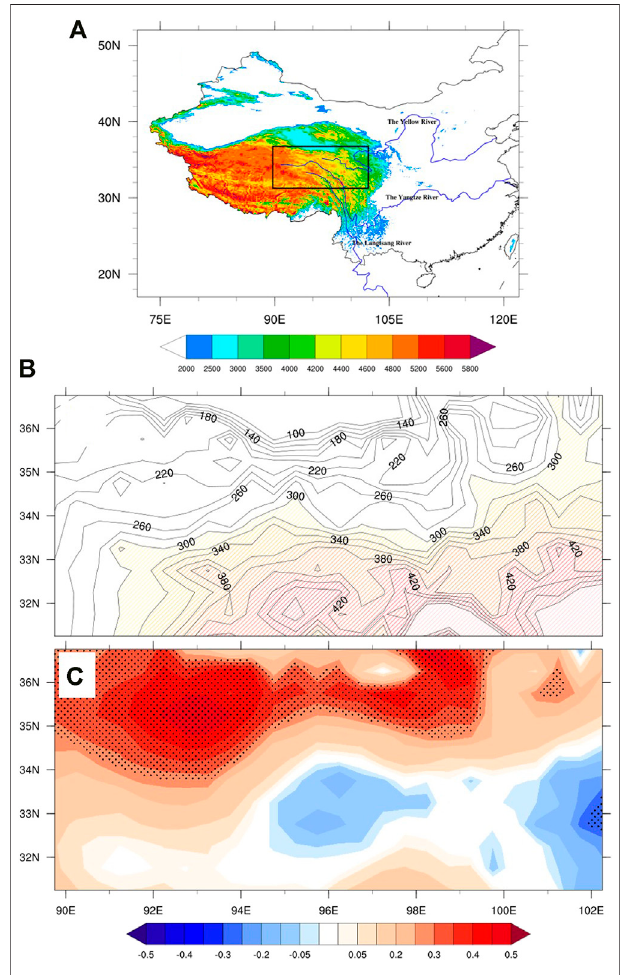
FIGURE 1 | (A) The topographical distribution (color shaded, unit in m) with the height exceeding 2000 m. (B) The climatology of the summer seasonal mean (June, July, and August) precipitation during the period of 1980 – 2017 over the TRHR (unit in mm). The shaded area represents precipitation exceeding 330 mm; (C) The trend of annual summer precipitation over the TRHR calculated from the gauge-based precipitation from 1980 to 2017 (unit in mm yr − 1 ). The observed station precipitation data are based on the gridded daily precipitation observation data with a spatial resolution of 0.25 ° × 0.25 °